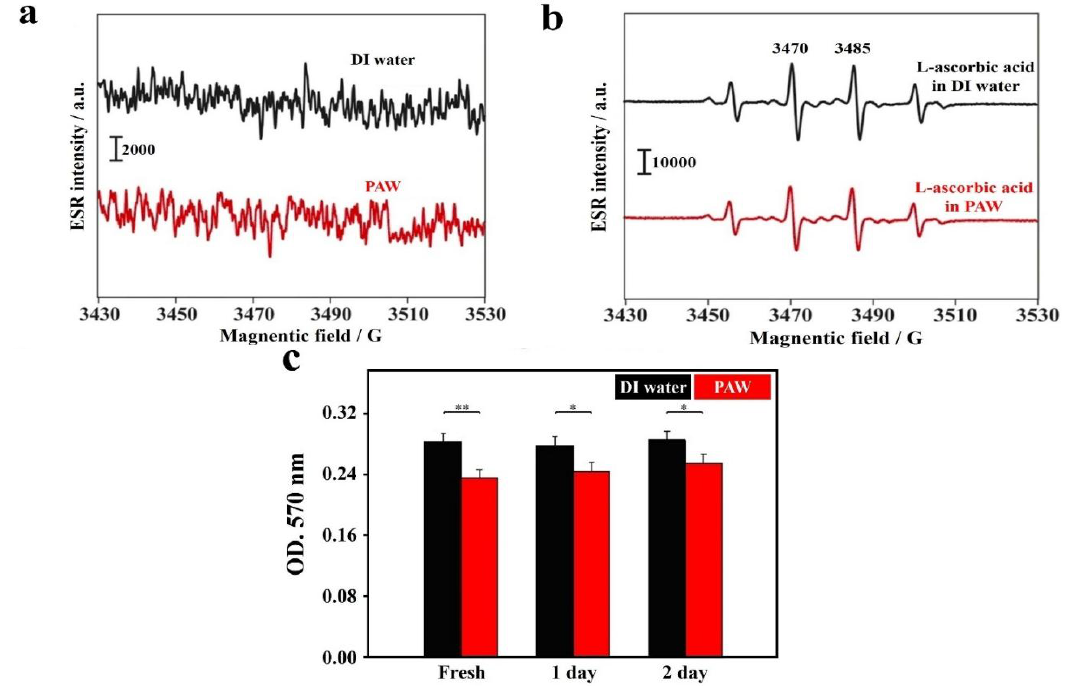
Figure 4. ESR spectra of hydroxyl free radicals and antioxidative effects based on DI water and PAW. ( a ) Spectra of DI water (black line) and PAW (red line) for reference; ( b ) Spectra of DI water plus the antioxidant L -ascorbic acid (black line) and PAW plus L -ascorbic acid (1.775 µM) (red line). Hydroxyl free radicals were obtained using the well-known Fenton reaction, in which ferrous iron donates an electron to hydrogen peroxide to produce a hydroxyl free radical; ( c ) Antioxidative effect of PAW to H 2 O 2 . The OD at 570 nm of H 2 O 2 (2.5 nm) prepared in DI and PAW waters. The corresponding p values are 0.00491, 0.0233, and 0.0357 for PAW after its preparation for 0, 1, and 2 days, respectively [77].